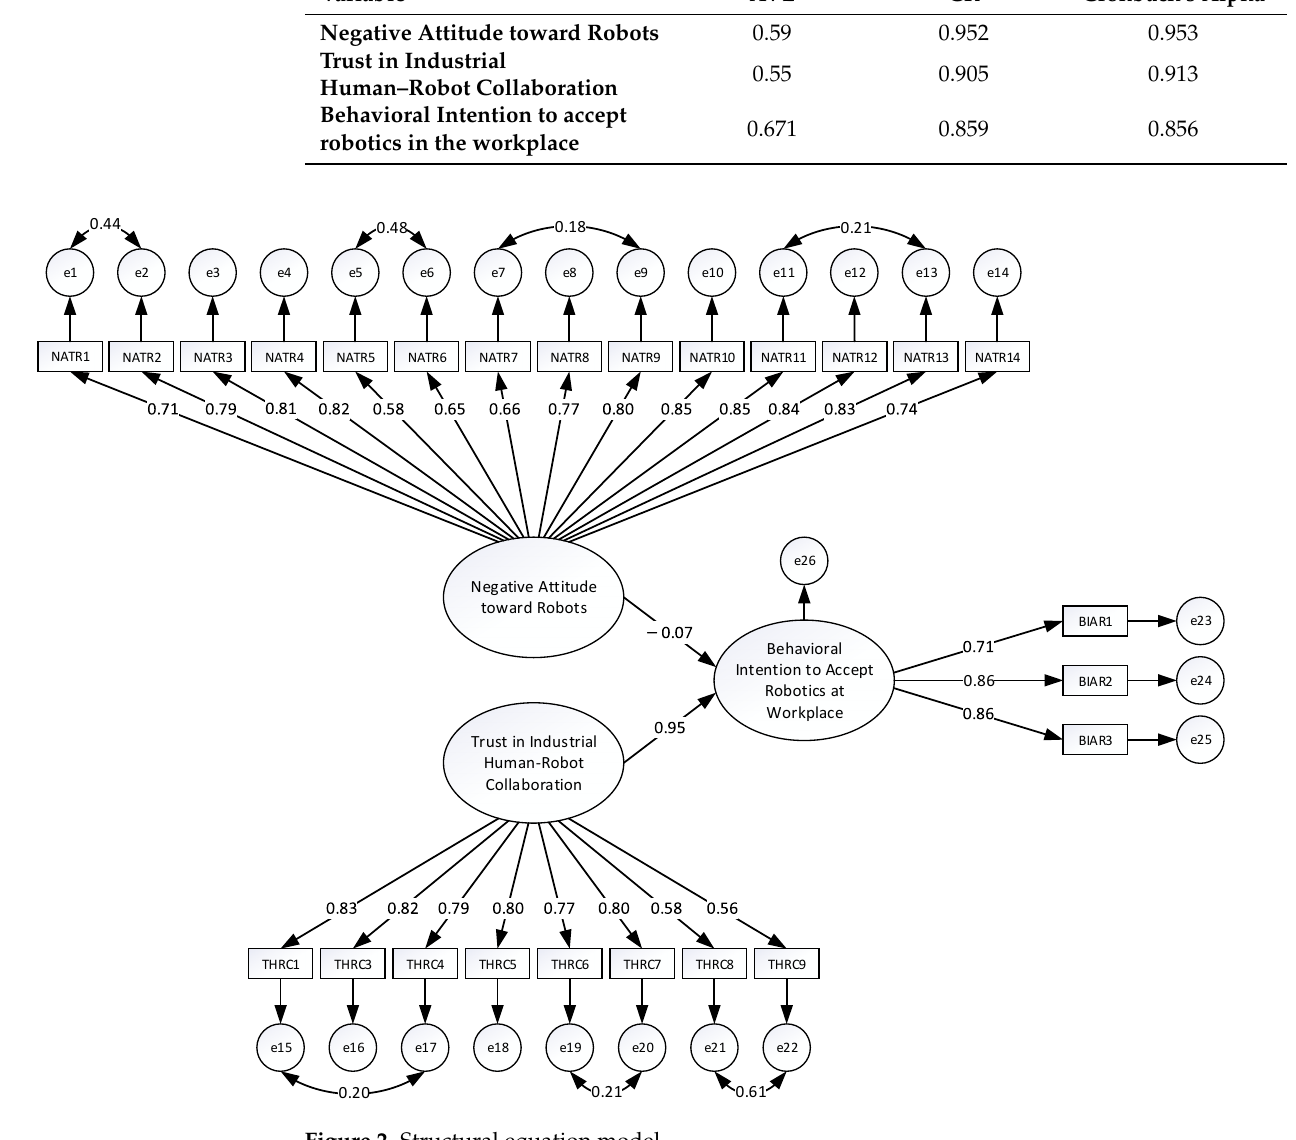
Figure 2. Structural equation model.